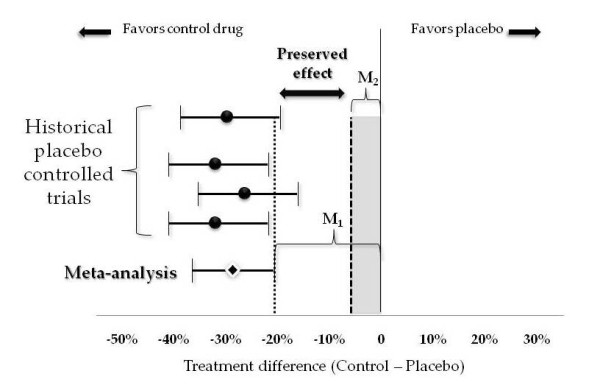
M2 as a fraction of M1.